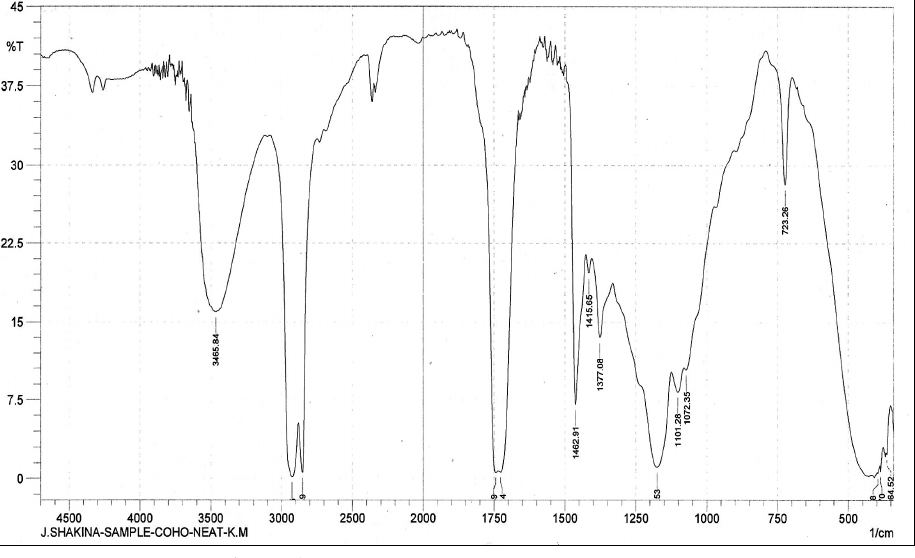
Figure 2. IR spectrum of hydroxylated olive oil